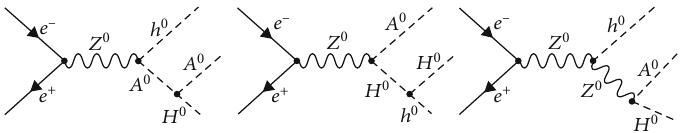
Figure 14: Feynman diagrams contributing to the scattering process e − e + ⟶ ZHH .